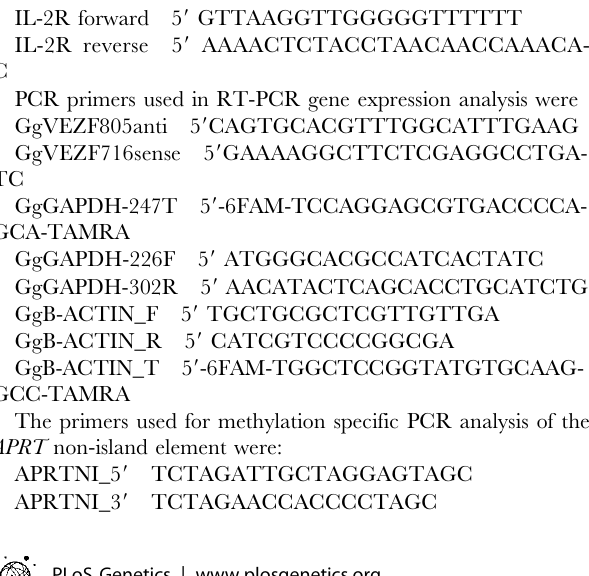
Figure S1 Core HS4 sequences. (A) The 244 bp Sac I - Hin dIII fragment originally defined as the ‘‘250 bp core’’ HS4 element [11]. Underlined bases indicate the positions of five in vitro DNaseI footprints [11]. Bases in bold type have been shown to be essential for DNA-binding of CTCF [9], USF1/2 [14], or VEZF1 (this study). This 244 bp fragment alone has not been tested in either enhancer blocking or barrier assays. (B) The 275 bp HS4 fragment used to define insulator properties of the ‘‘250 bp core’’ in enhancer blocking [9] and barrier assays [12]. Flanking Asc I cloning sites present in all functional assays of the HS4 core are shown in italics. Figure S2 Identification of FI- and FIII-binding proteins. (A) Peptide sequences obtained from tandem MS sequencing of proteins isolated by FI- and FIII-DNA affinity. (B) Alignment of the amino acid sequences of chicken VEZF1/BGP1, human VEZF1/DB1, and mouse Vezf1 (accession numbers AY775302, 1082846, and 7710108). Peptides obtained from tandem MS sequencing that match VEZF1 are indicated by lines above the alignment. Six C2H2 zinc fingers motifs are boxed. (C) Schematic representation of the domain structure of VEZF1. Only the zinc finger motifs share homology with factors other than VEZF1 orthologs, the nearest relative being the MAZ transcription factor. Figure S3 Supershift analysis of VEZF1, SP1, SP3, and ZF5 interactions with HS4 footprints and the b A -globin promoter. Gel mobility supershift assays using 32 P-labelled FI (A), FIII (B), FV (C), and glo wt (D) oligonucleotide duplexes. Adult chicken erythrocyte nuclear extract (ery) and recombinant chicken VEZF1, SP1, or SP3 used in the reactions are indicated by brackets above the lanes. Proteins were pre-incubated with antibodies (indicated above each lane) prior to incubation with DNA. Supershifts are evidenced by abrogation of specific complexes (asterisks) and/or formation of low mobility ternary complexes (SS). Antibodies alone do not give rise to complexes with any of the duplexes used (not shown). Figure S4 Analysis of SP1, SP3, and ZF5 interactions with HS4 footprints I and III. Gel mobility shift assays using 32 P-labelled FI and FIII oligonucleotide duplexes. Unlabelled competitor duplexes (indicated above each lane) were added at 50 fold molar excess. Recombinant chicken SP1, SP3, and ZF5 used in the reactions are indicated by brackets above the lanes. The competition profile of these proteins does not match that of red blood cell nuclear extract (Figure 4) or recombinant VEZF1 (Figure 6A). Figure S5 SP1, SP3, and ZF5 do not interact with HS4 in vivo . (A) ChIP analysis of transcription factor interactions at the b -globin locus in 6C2 erythroid progenitor cells. DNA enrichments at the {lower case beta}A promoter or the HS4 and 3 9 HS insulators were normalized to a negative control located in the 16 kb condensed chromatin region upstream of the b -globin locus. (B) ChIP analysis of transcription factor interactions with a stably integrated HS4 element in transgenic human 293 cells. Interac- tions with the DHFR CpG island promoter are shown as a positive control for SP1 and SP3 binding. DNA enrichments are normalized to an AT-rich negative control locus. Figure S6 VEZF1 binding to HS4 is resistant to individual binding site mutations. (A) Schematic representation of the IL-2R